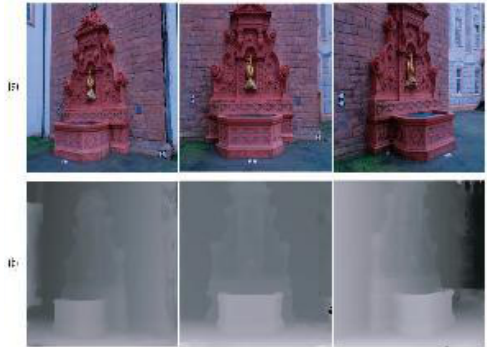
Fig.8- (a) Frames 2, 5, and 8. (b) The estimated depth maps